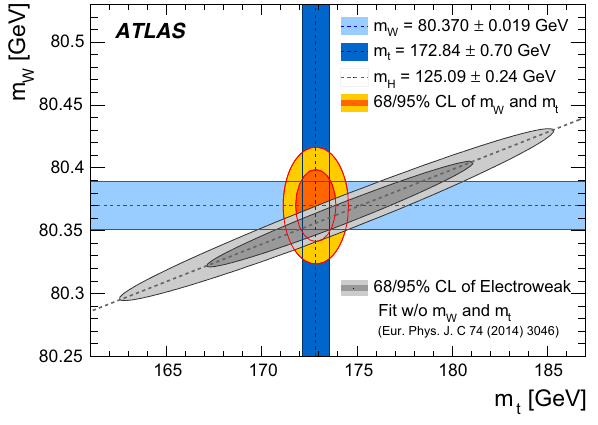
Fig. 1 Replacement of Fig. 30: The 68% and 95% confidence-level contours of the m W and m t indirect determination from the global electroweak fit [1] are compared to the 68 and 95% confidence-level contours of the ATLAS measurements of the top-quark and W -boson masses. The determination from the electroweak fit uses as input the LHCmeasurementoftheHiggs-bosonmass, m H = 125 . 09 ± 0 .